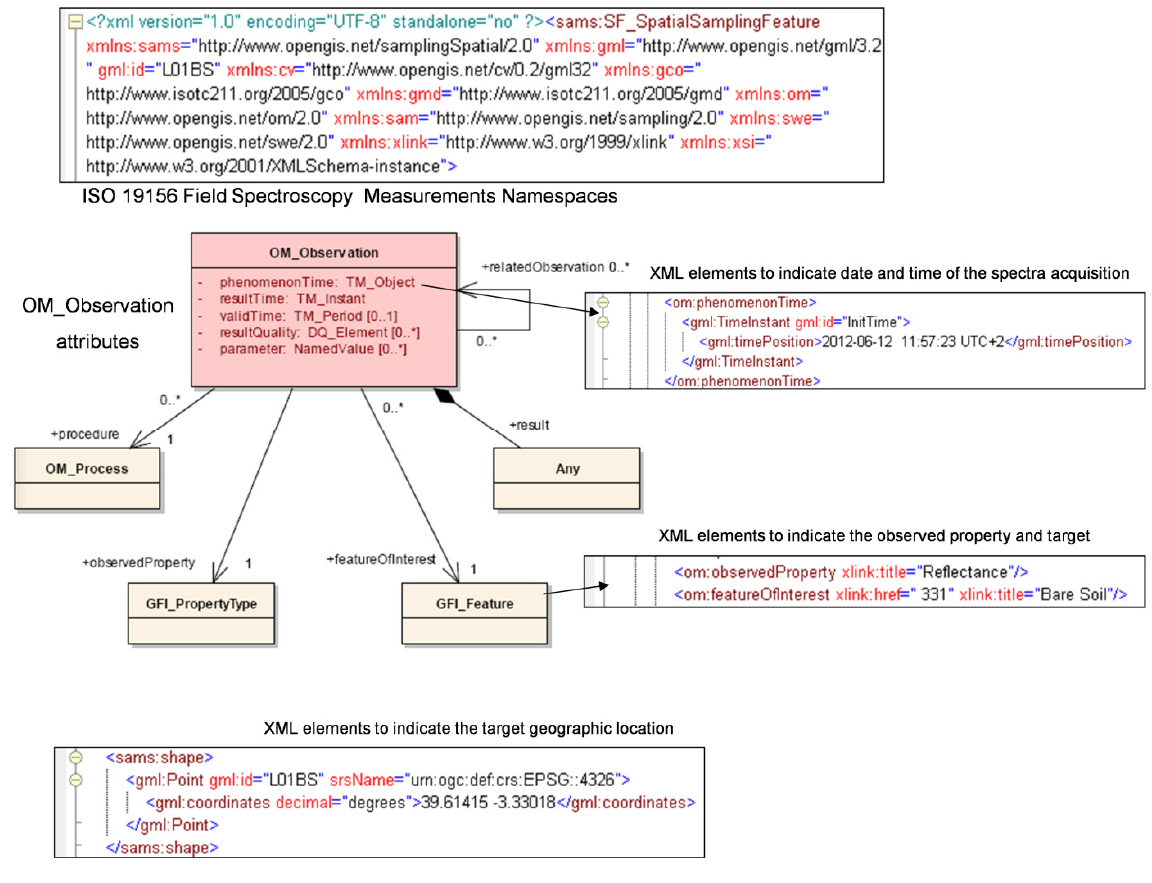
Figure 5, the srsName has urn:ogc:def:crs:EPSG:6.8:4326 to indicate that the coordinate reference system for the spectral library acquired is